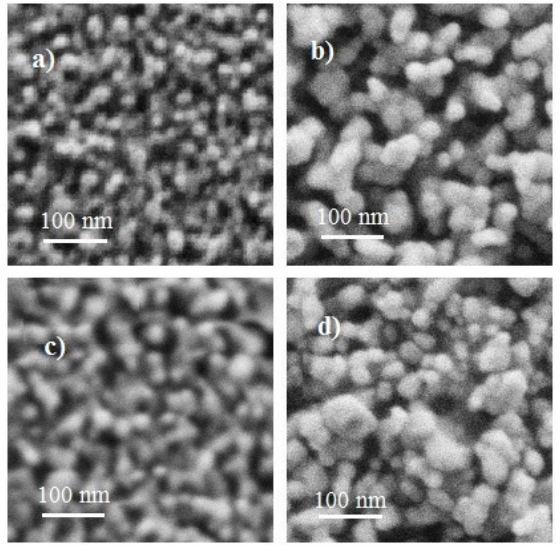
Figure 2. SEM micrographs of Cu-doped ZnO thin films prepared from copper chloride by ( a ) six and ( b ) eight dips and Cu-doped ZnO thin films prepared from copper acetate by ( c ) six and ( d ) eight dips.